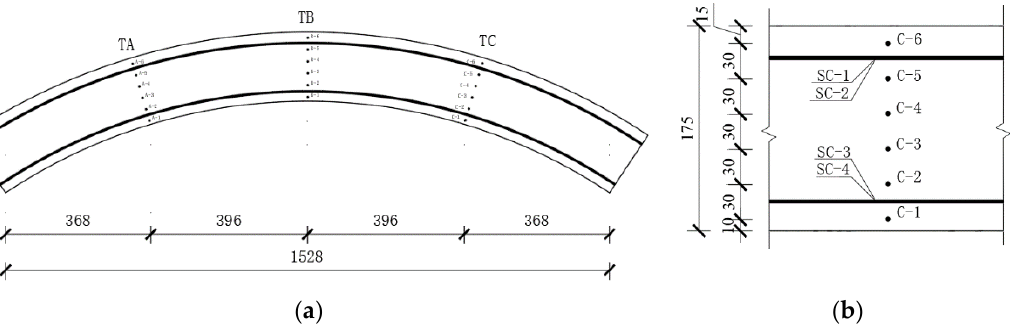
Figure 4. Layout plan of segmented thermocouple (Unit: mm): ( a ) Plane figure; ( b ) Measurement point arrangement in the cross-section.